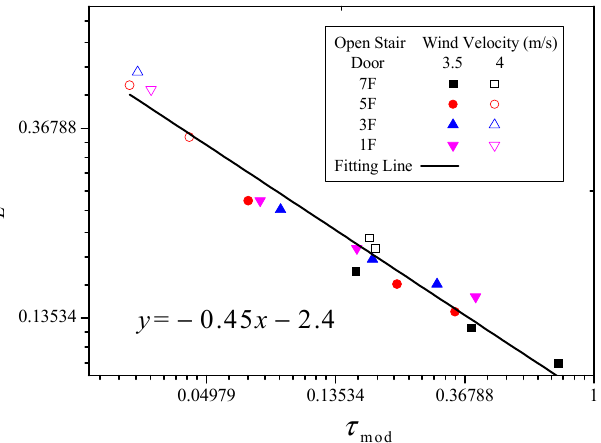
Figure 15. Dimensionless back-layering distance L * versus modified dimensionless back-layering time τ mod .